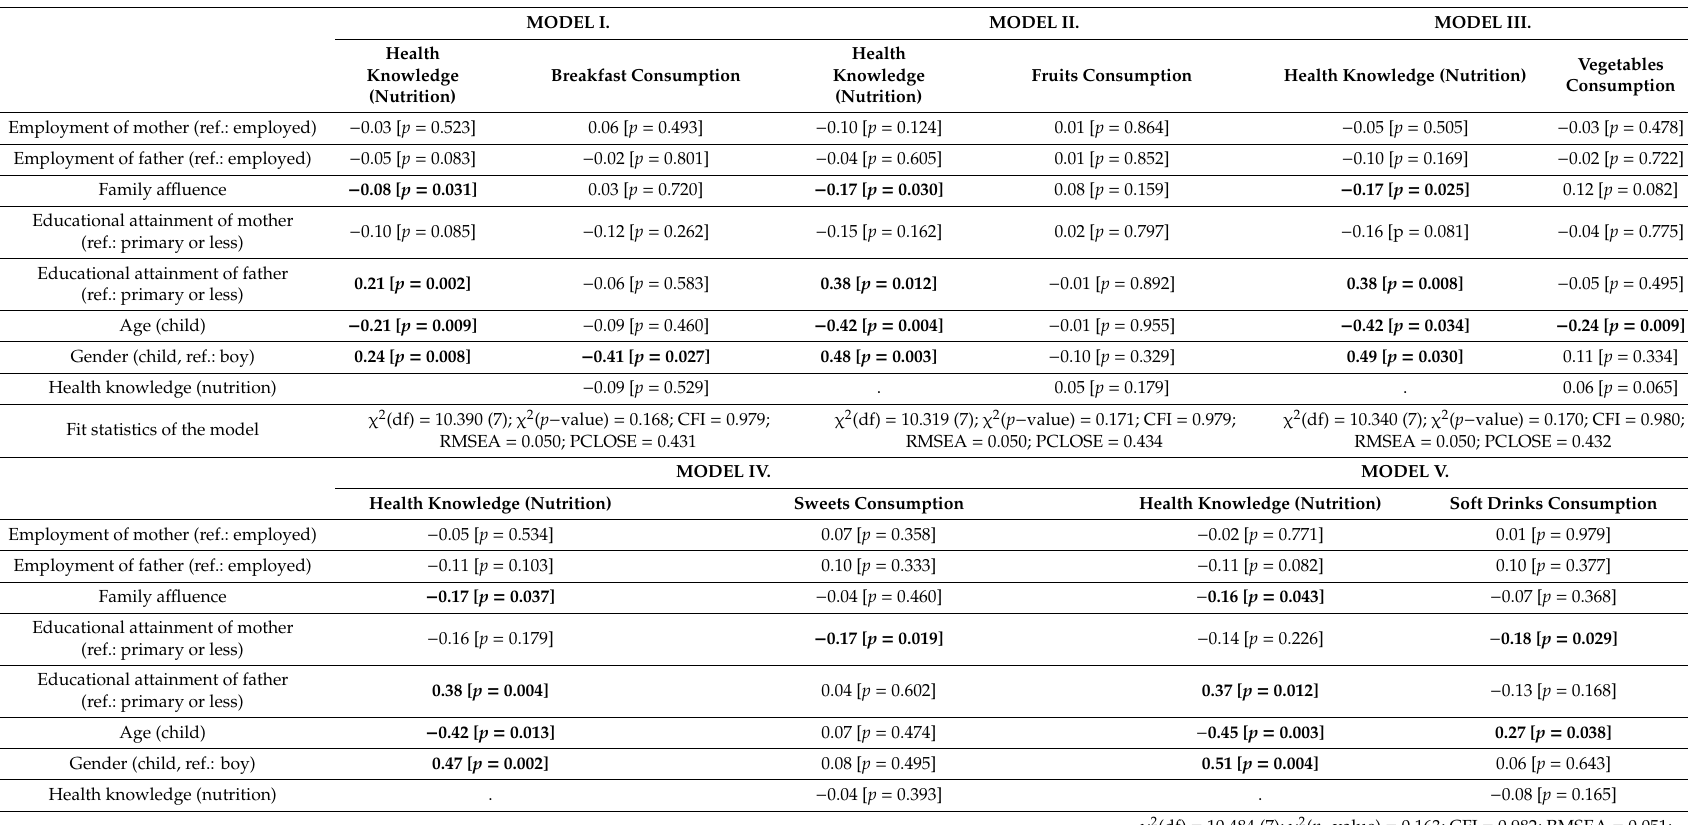
Table 3. Structural equation modelsˆ of health-related knowledge and health